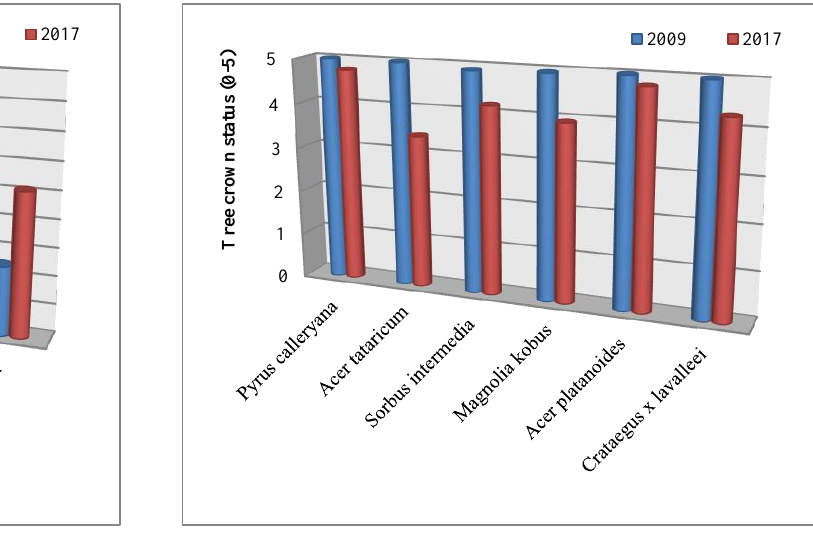
Figure 4. Tree crown status of six tree taxa in streets of Debrecen in 2009 and 2017.